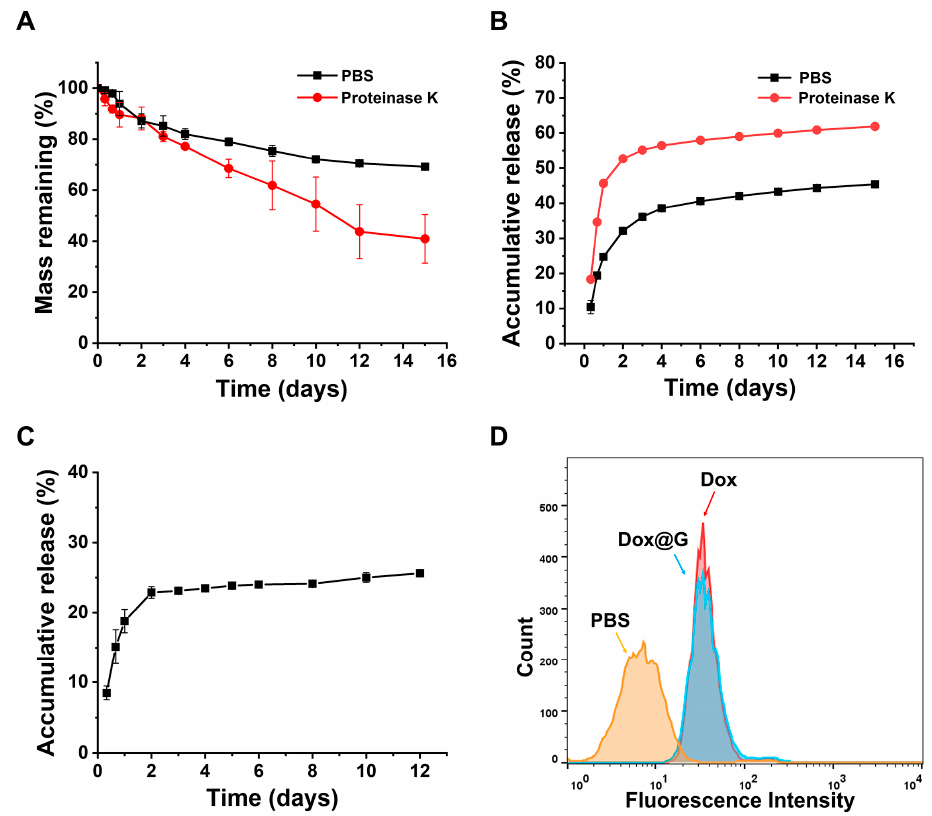
Figure 2. ( A ) In vitro degradation behaviors of 6 wt% hydrogel in PBS or PBS containing proteinase K (5 U/mL) ( n = 3). ( B ) Accumulative Dox release profiles from 6 wt% hydrogels in PBS or PBS containing proteinase K (5 U/mL) ( n = 3). ( C ) Accumulative IgG release from 6 wt% hydrogel in PBS ( n = 3). ( D ) Fluorescence intensity of CRT expressed on B16F10 cells after different treatments.